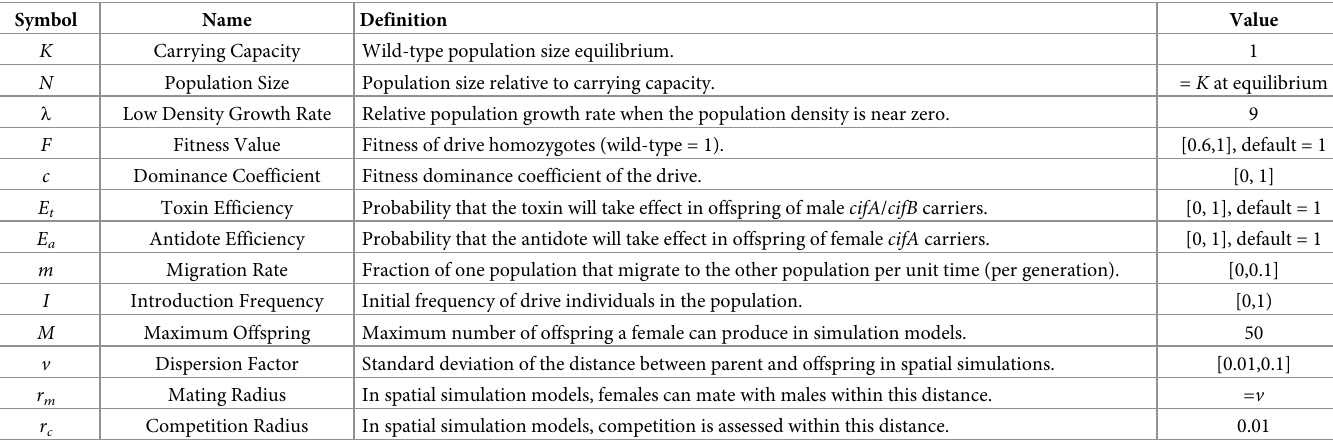
Table 1. Important parameters used in models of CifAB